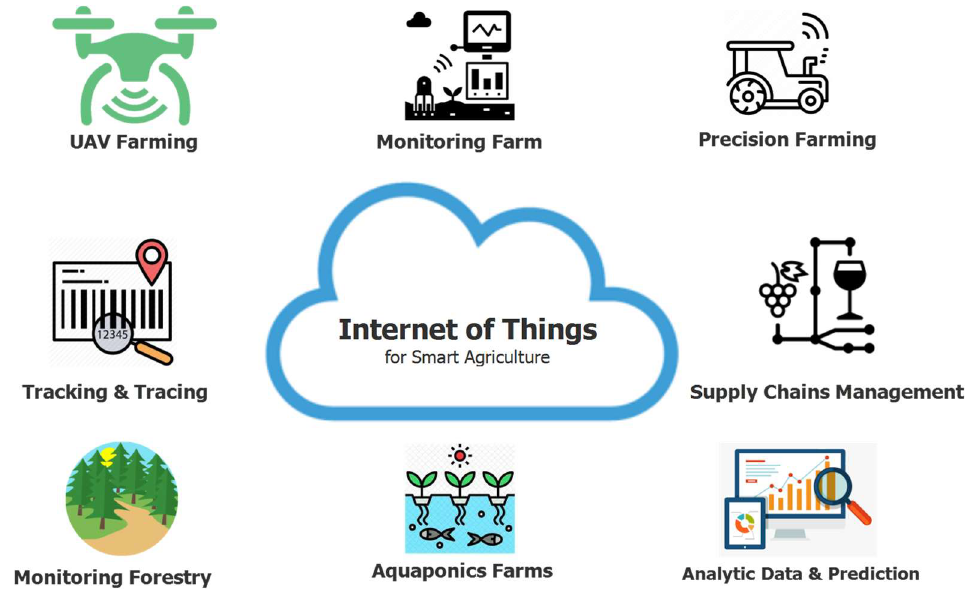
Figure 1. An illustration of IoT applications for smart agriculture.